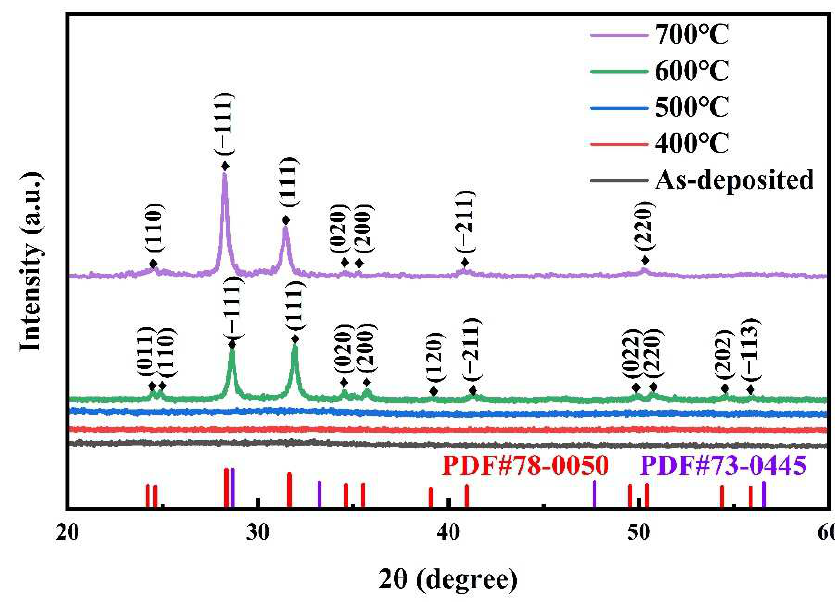
Figure 1. XRD patterns of lanthanum-doped HfO 2 films at different temperatures.